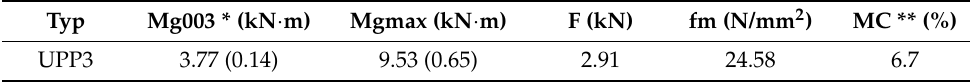
Table 7. Physical and mechanical properties of UPP3 lattice beam loaded at 8